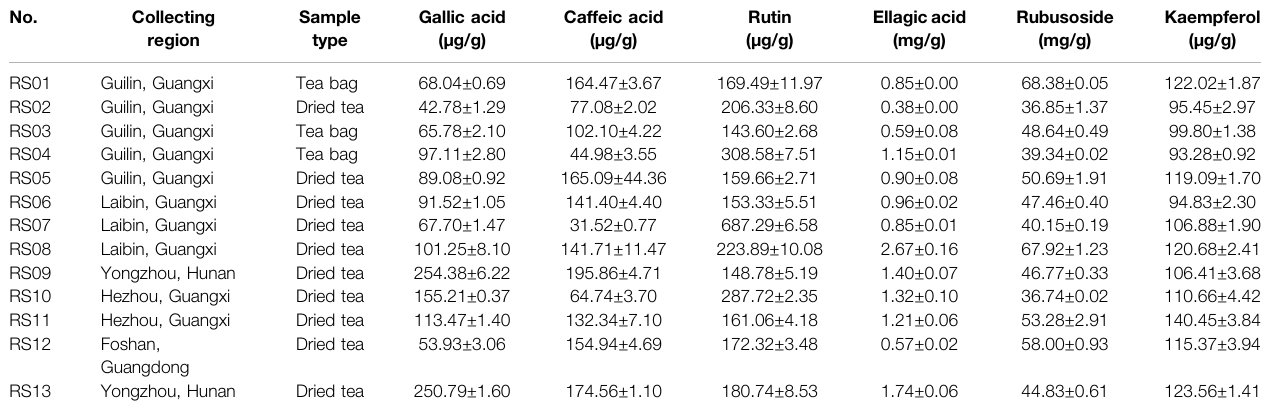
TABLE 3 | Content of six compounds in 13 batches of Rubus chingii var. suavissimus samples from markets ( μ g/g or mg/g, mean ± SD, n (cid:2) 3 ). No.